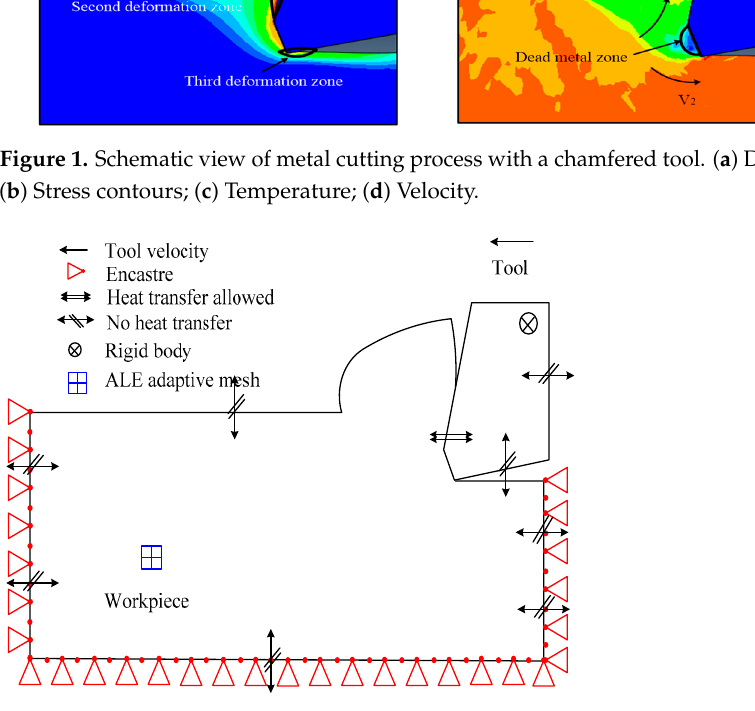
Figure 2. Description of the ALE model.